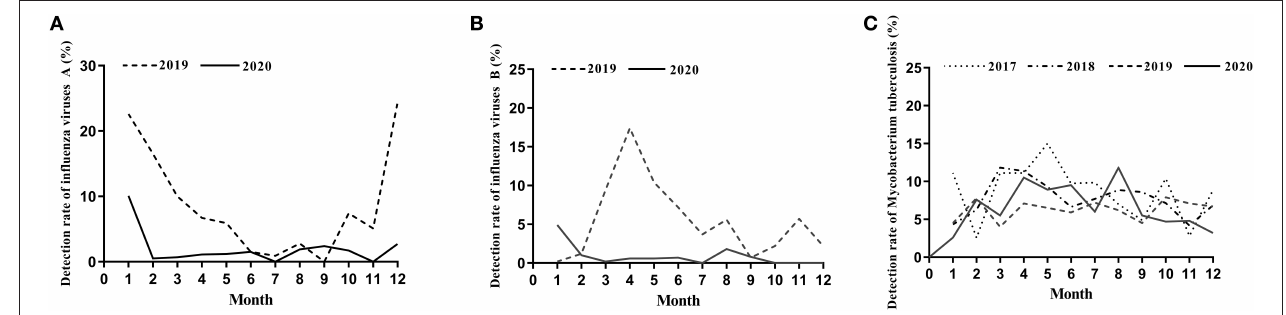
FIGURE 1 | The detection rate of influenza viruses and Mycobacterium tuberculosis. (A) The detection rate of influenza viruses A from January to December during 2019–2020. (B) The detection rate of influenza viruses B from January to December during 2019–2020. (C) The detection rate of Mycobacterium tuberculosis from January to December during 2017–2020.